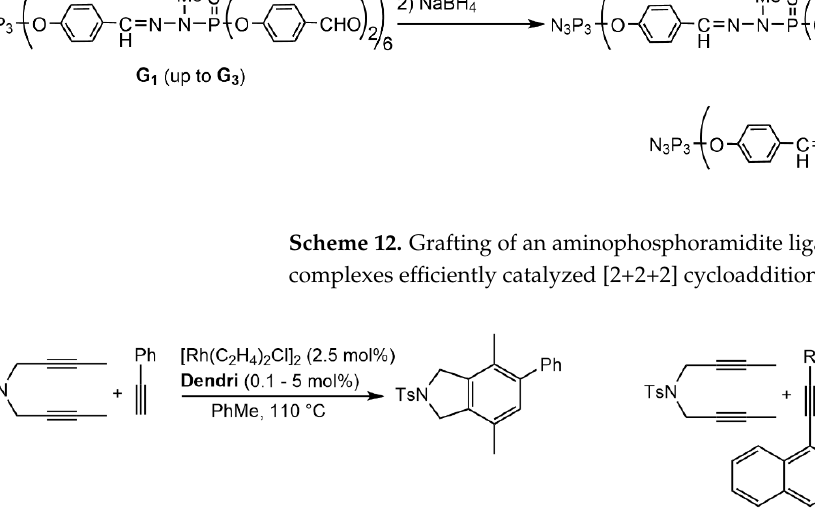
Figure 7. [2+2+2] cycloaddition reactions catalyzed by the Rh complex of the dendrimers shown in Scheme 12.